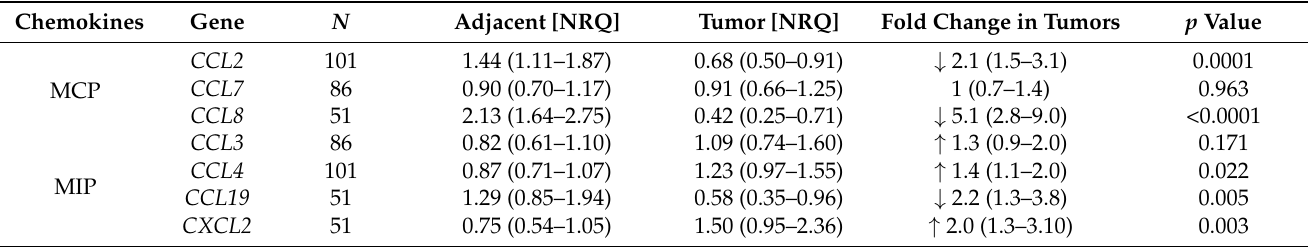
The data are presented as geometric means with a 95% confidence interval, and were analyzed with a t -test for paired samples. The fold-change in tumor tissue compared to the adjacent non-transformed tissue is marked as decreased ( ↓ ) or increased ( ↑ ). N , number of paired observations available for analysis; NRQ, normalized relative quantity.